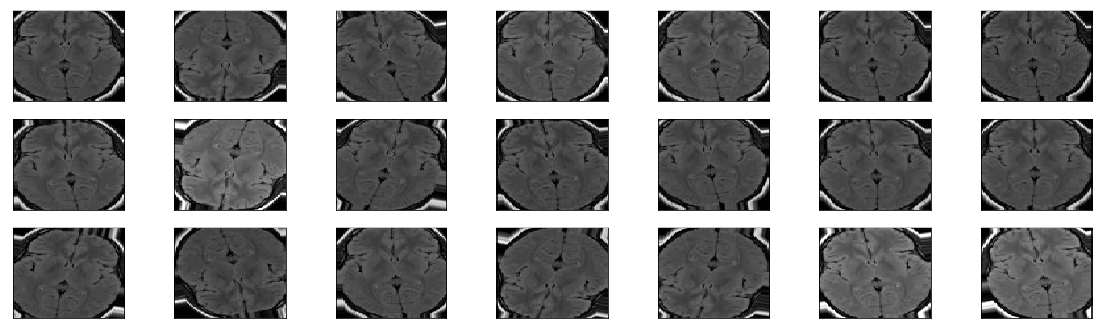
Figure 3. Augmented images: Each of the 21 displayed images are generated from the same input image by introducing slight variations such as rotation, sheer, zoom, brightness, shift and horizontal flip with the aim of building a generalized and robust